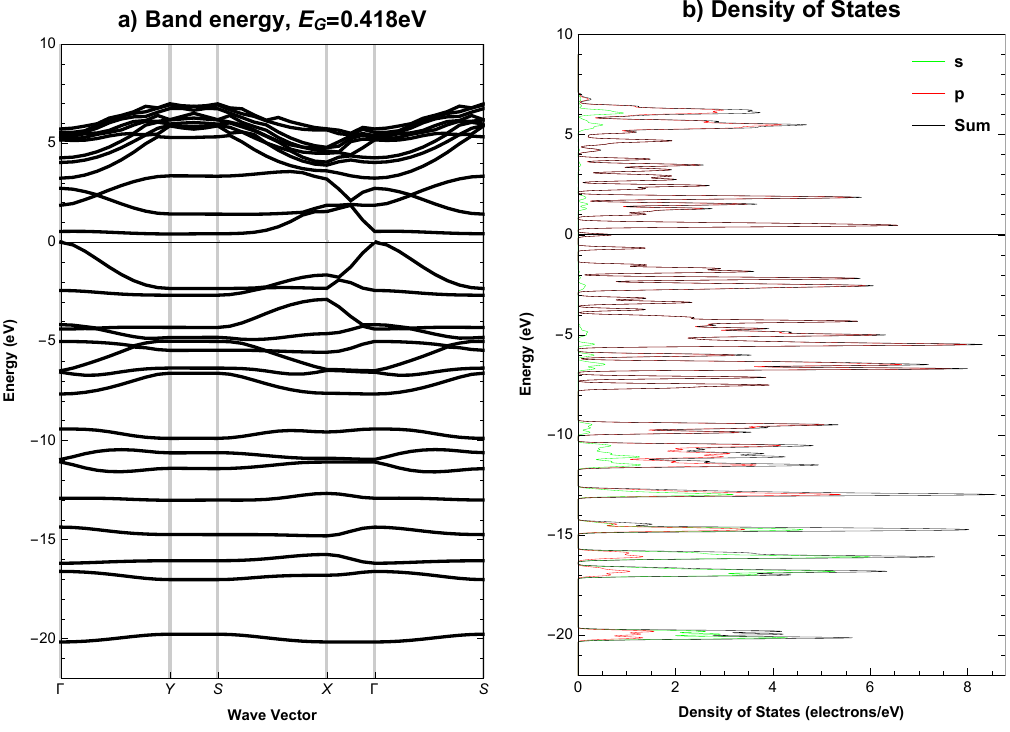
Figure 3. Anisotropic-cyclicgraphene —( a ) electronic band structure and ( b ) total and partial density of states(GGA functional). The Fermi level E F is set to 0.